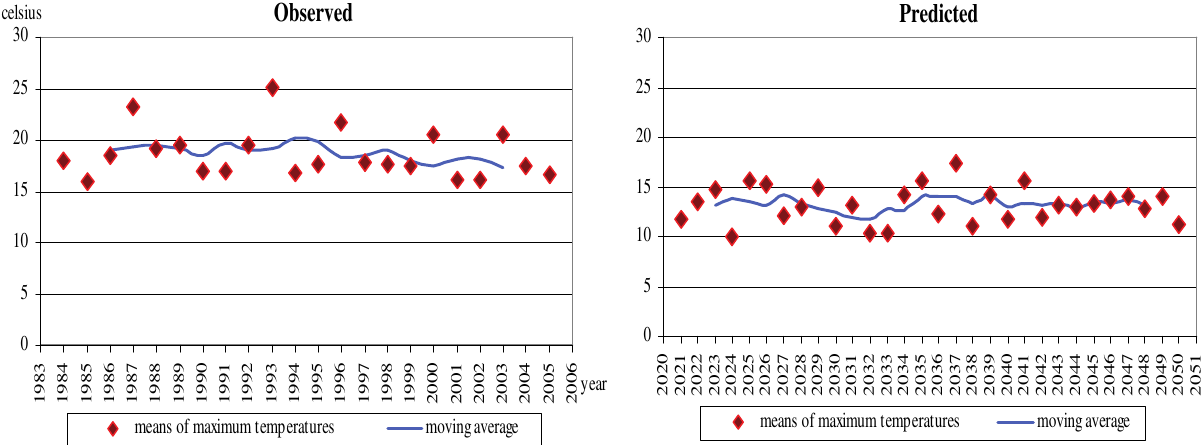
Figure 5: The observed (Left) and estimated (Right) means of maximum temperatures at Újfehértó. Estimations have been made by means of the RegCM 3.1 model for the period 10 days before bloom plus blooming time